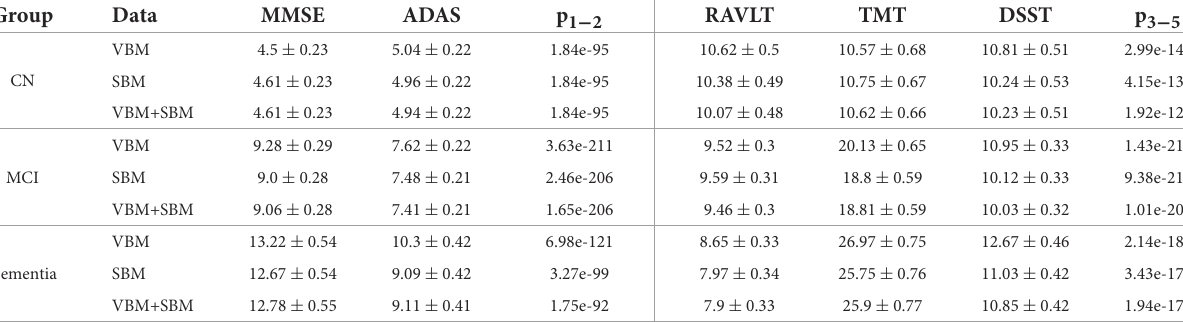
TABLE 3 Performance of models trained on cognitively preserved population, subjects diagnosed with MCI, or dementia with adjustment to the range of values (MAE/range, %).